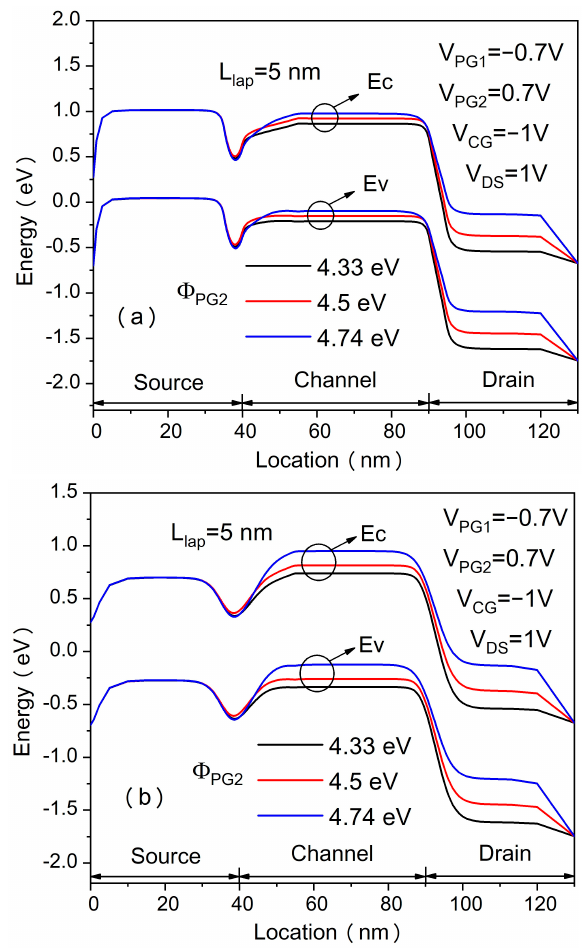
Figure 6. Energy band diagrams at ( a ) 1 nm and ( b ) 5 nm below the Si–oxide interface of the proposed ED-TFET with an ED drain at OFF state with Φ PG2 of 4.33eV (black), 4.5eV (red) and 4.74eV